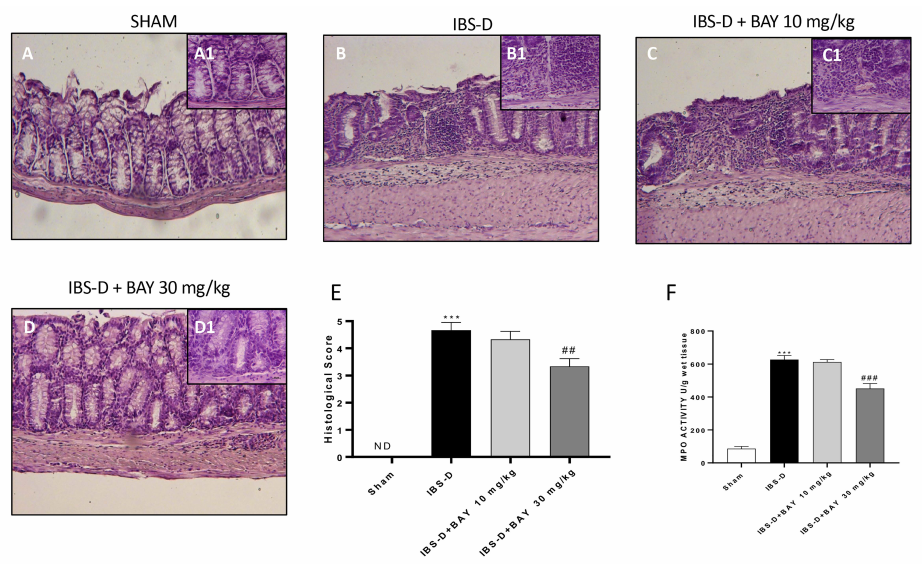
Figure 3. Effect of BAY 11-7082 treatment on histological damage. Extensive damage to the colon tissue was observed in the IBS-D group ( B ) compared to the sham group ( A ). BAY treatment at the dose of 30 mg / kg ameliorated architecture tissue ( D ) more than BAY treatment 10 mg / kg as shown in ( C ). Moreover, as shown in ( F ), the treatment with BAY treatment 30 mg / kg significantly reduced MPO activity more than BAY treatment 10 mg / kg. Data are representative of at least three independent experiments. ( E ) *** p < 0.001 vs.